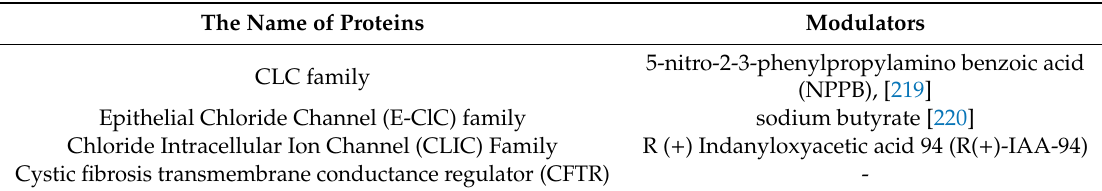
Proteins that regulate chloride ion dynamics involved in carcinogenesis with potential